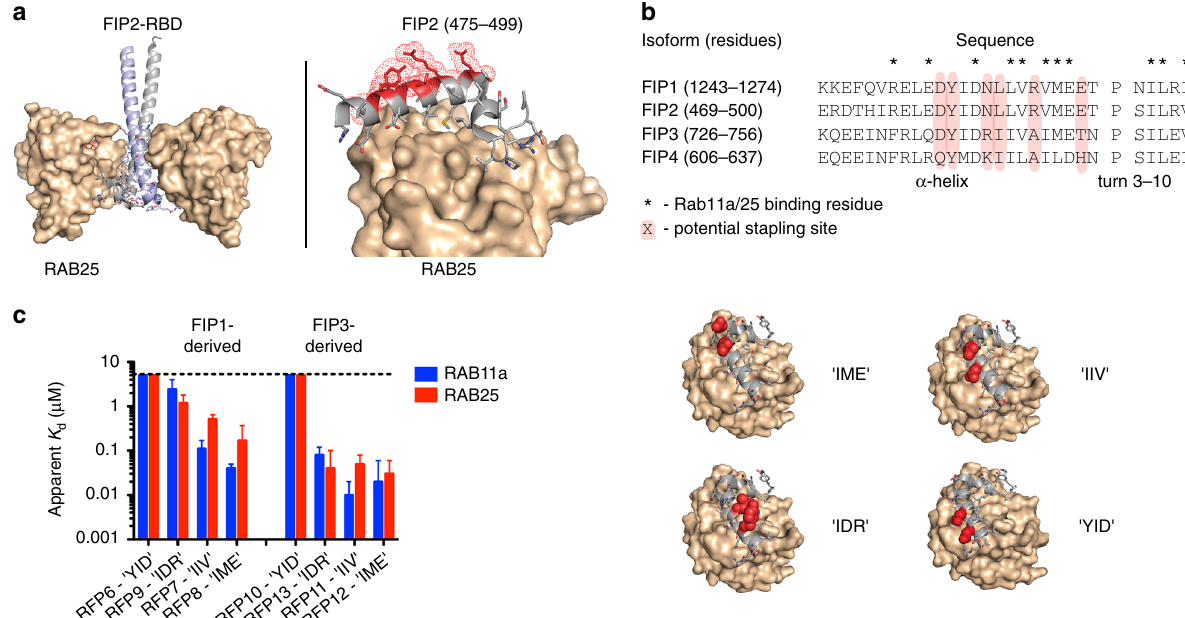
Fig. 1 Development of stapled peptide ligands targeting RAB11a and RAB25. a Crystal structure of the RAB25:FIP2 heterotetramer ( left ). The C-terminal RAB-binding domain of FIP2 binds as a helix-turn-helix peptide ( gray and blue ) to a hydrophobic groove on RAB25 ( tan surface ). Side chains not involved in RAB25 binding are highlighted as red surfaces while others are shown as sticks ( right ). PDB accession: 3TSO. b Sequence alignment of the RAB-binding domains from Class-I (FIP1 and 2) and Class-II (FIP3 and 4) FIP proteins. Residue annotations were assigned based on published RAB11a:FIP3 and RAB25: FIP2 crystal structures. c Graphical depiction of apparent af fi nities for initial series of FIP1- and FIP3-derived stapled peptides for binding to both RAB11a and RAB25. Each peptide stapling position is denoted by the residues in FIP3 spanned by the hydrocarbon staple (e.g., “ IIV ” ), highlighted in red on the schematic structures shown ( right ). The af fi nity graphs show the mean apparent K d with error bars representing the 95% con fi dence interval from triplicate replicates and application of a sigmoidal curve fi t using Prism 5